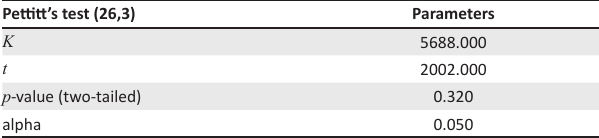
TABLE 5: A decal drought frequency